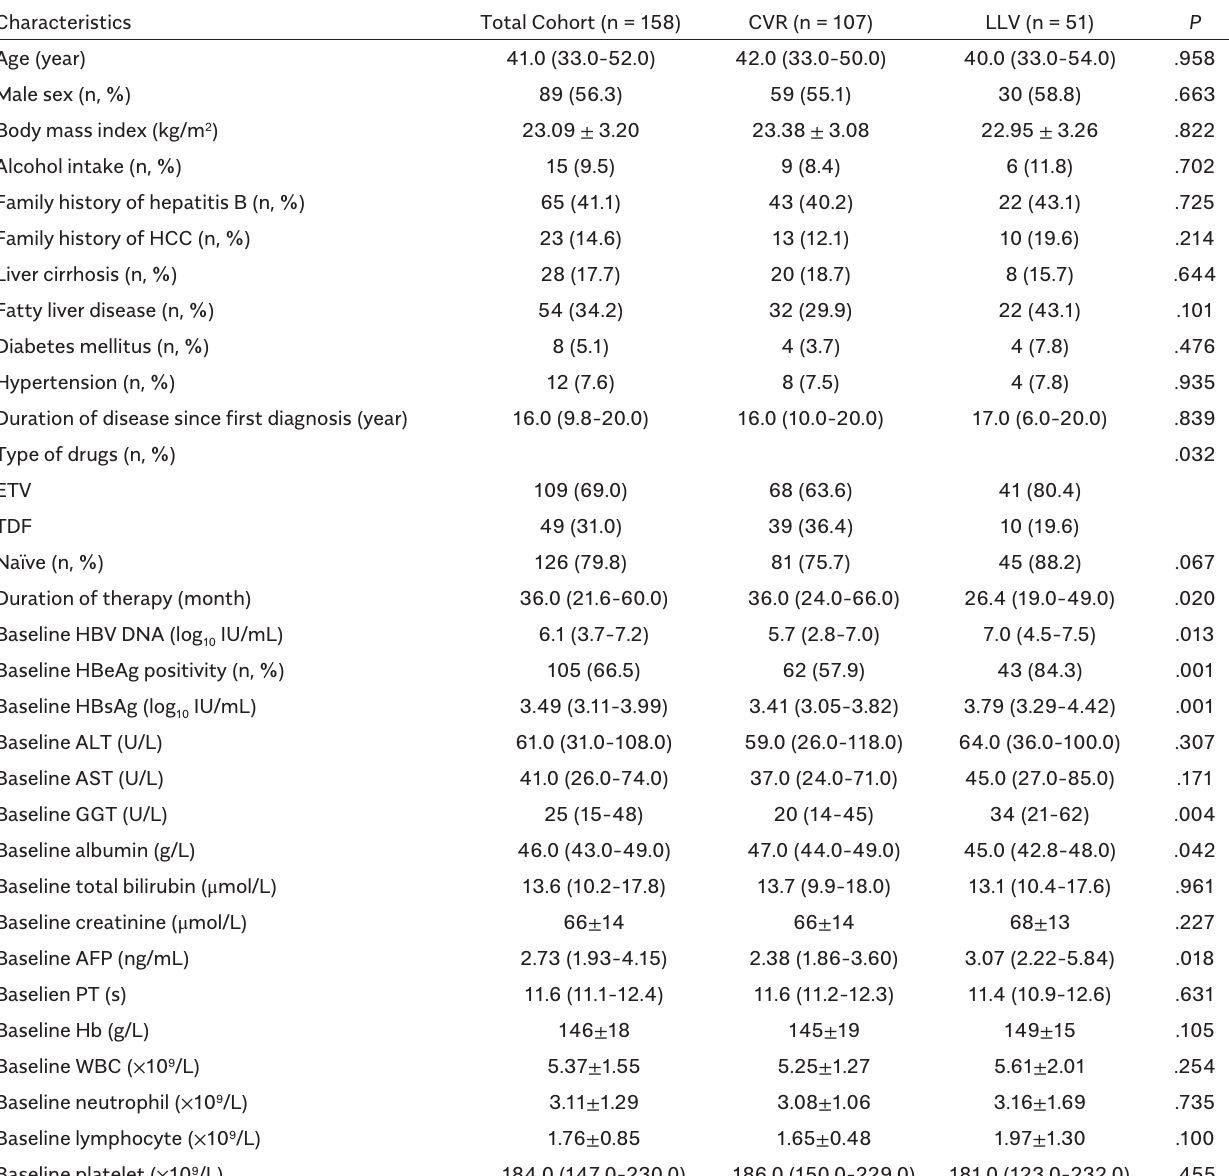
Table 1. Clinical Characteristics of CHB Patients with CVR or LLV